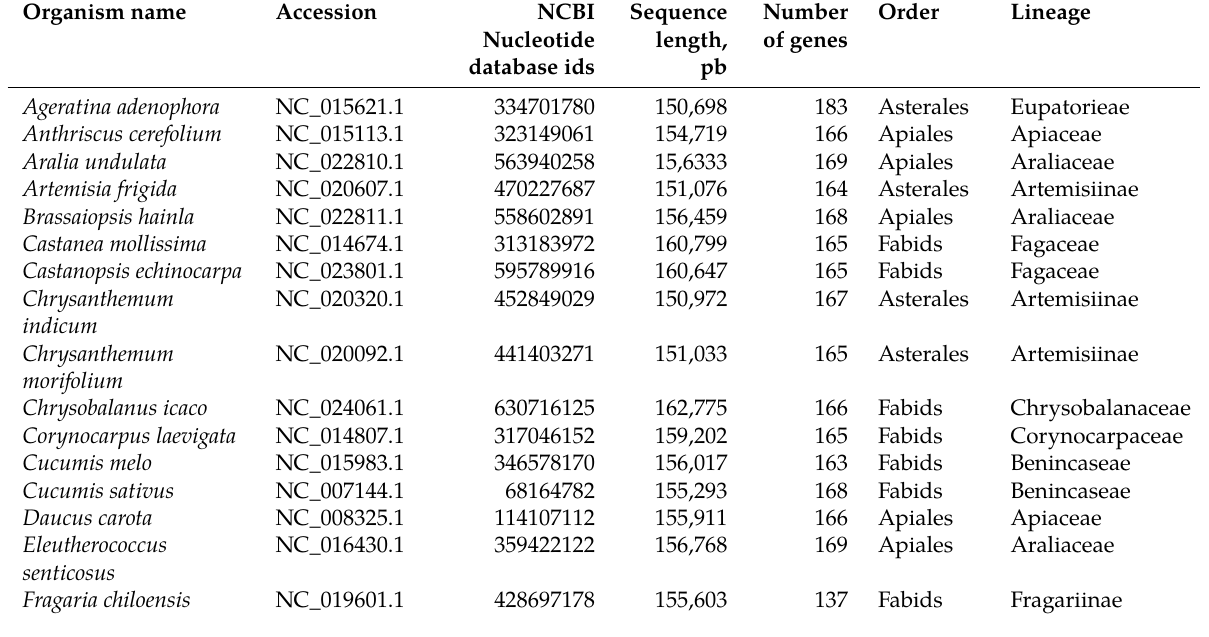
Table 1: Genomes information of all considered